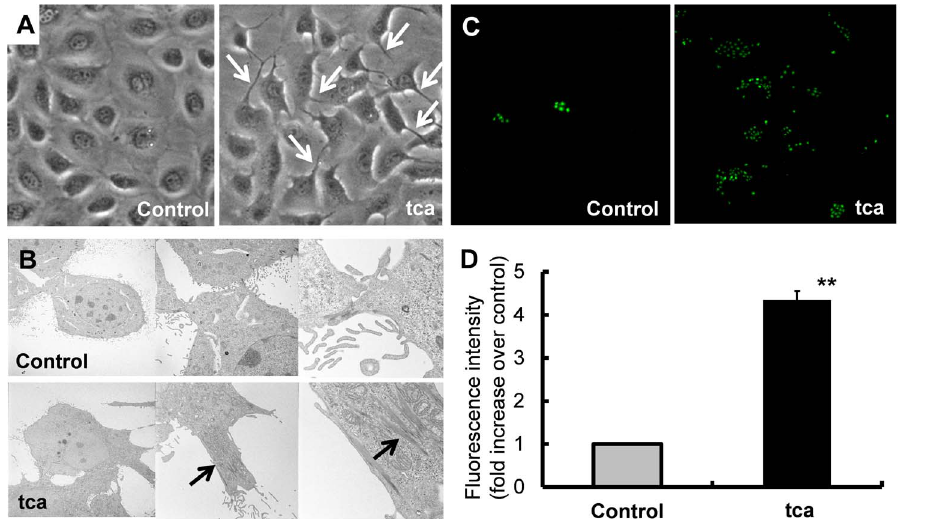
Figure 4. Effects of TCA exposure on ESCC-DR cell morphology and invasion. (A) Podia formation (white arrow) in tca cells (magnification 6 400). (B) Thick bundles of actin filaments (black arrows) associated with podia formation (magnification 6 1740, 6 4860 and 6 18400). (C) Fluorescence microscopy demonstrated the invasion of control and tca cells through Matrigel-coated membranes toward DMEM containing 5% FBS. (D) The rate of invasion was four-fold higher in tca cells compared with control cells (** P , 0.01).